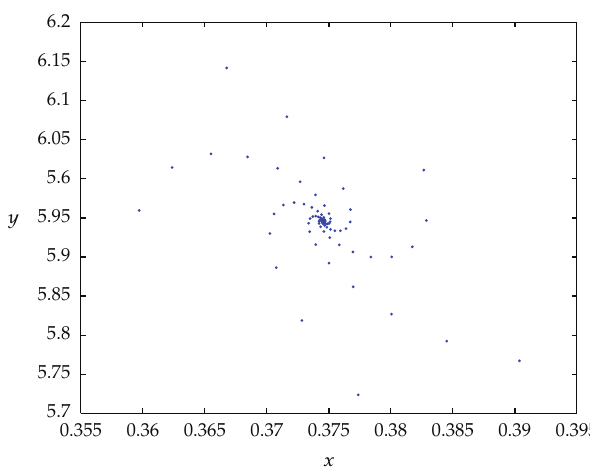
Figure 18: An attracting fixed point for system (cid:3) 2.2 (cid:4) for a (cid:8) 3 . 5, b (cid:8) 0 . 2, and d (cid:8) 2 . 67.